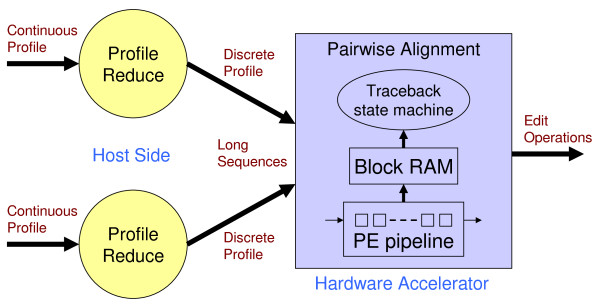
Profile reduction before alignment.